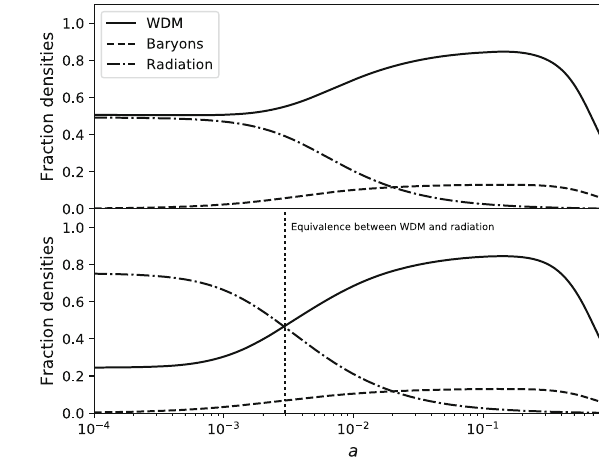
Fig. 1 Left panel: Comparison between radiation density and WDM density for several values of b 2 . For the values b 2 (cid:2) 10 − 6 there is no radiation dominated era and WDM always dominates after infla-